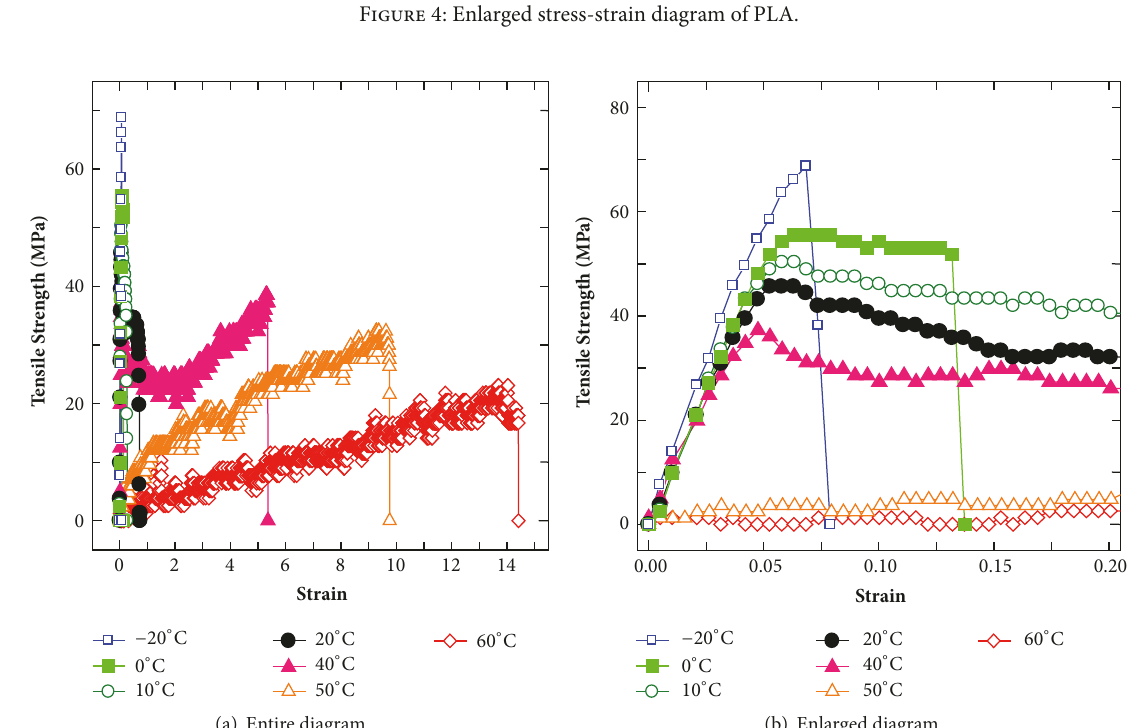
Figure 5: Stress-strain diagram of